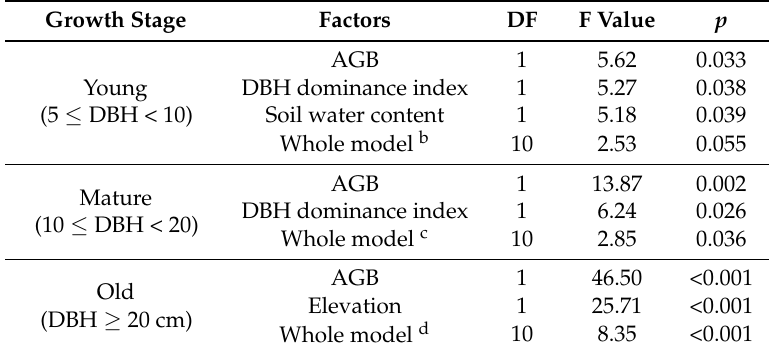
Table 2. Summary of general linear models for the effects of biotic and environmental factors on the richness of young trees, mature trees, and old